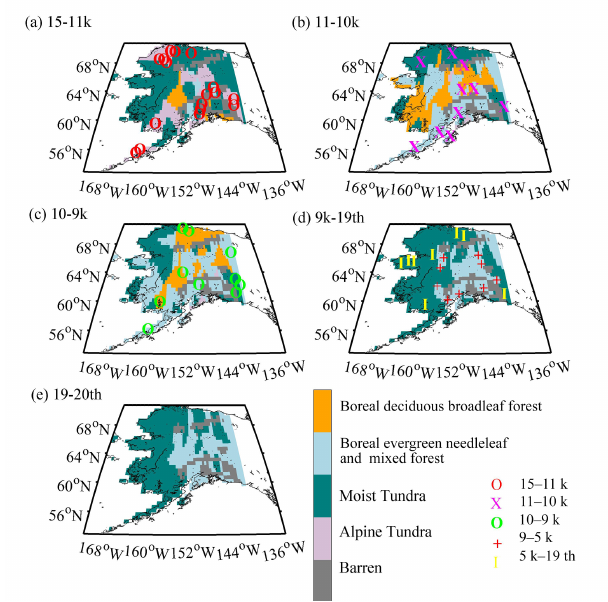
Figure 2. Alaskan vegetation distribution maps reconstructed from fossil pollen data during (a) 15–11ka, (b) 11–10ka, (c) 10–9ka, (d) 9ka–1900AD, and (e) 1900–2000AD (He et al., 2014). Sym- bols represent the basal age of peat samples ( n = 102) in Gorham et al. (2012). Each symbol indicates one to three peat samples in the map. Peat samples with basal age 9–5k and 5k–19th are shown in map (d) as there is no change in vegetation distribution during 9k– 19th. Barren refers to mountain range and large water body areas that can not be